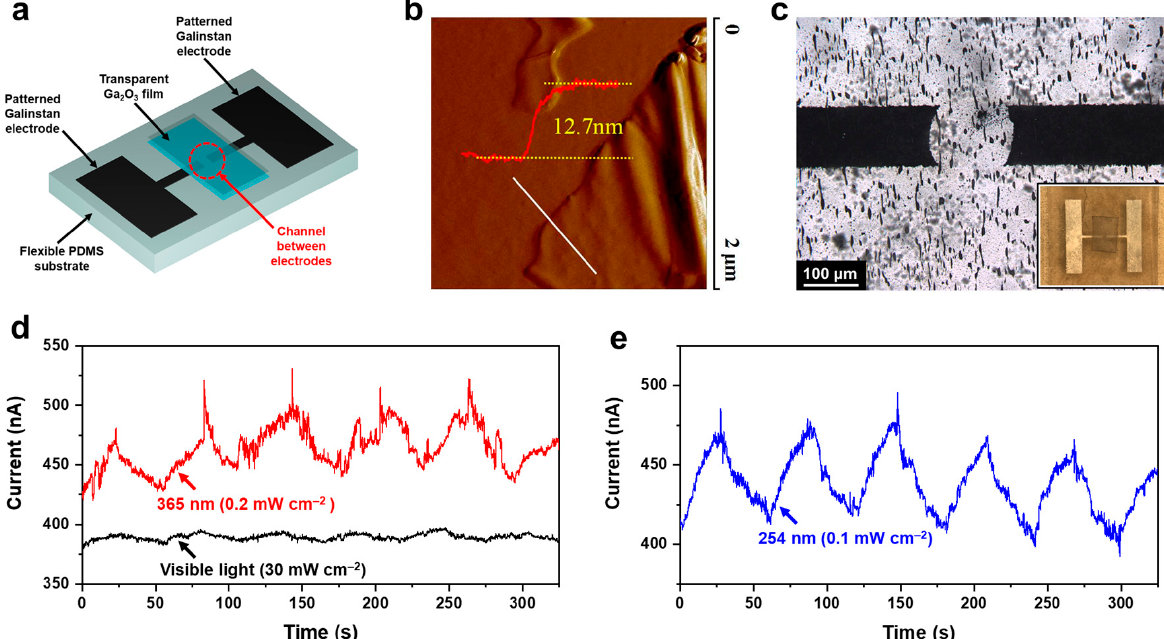
Figure 5. ( a ) Schematic illustration of solar-blind photodetector. ( b ) AFM image of transparent Ga 2 O 3 film, exfoliated using a PDMS stamp. The height profile along the white line is also indicated. ( c ) Optical microscopy image of a channel between two patterned Galinstan electrodes. The black areas correspond to Galinstan beneath the transparent Ga 2 O 3 film. Photograph of the fabricated photodetector is also shown in the inset. ( d ) Output characteristics of the solar-blind photodetector under irradiations of visible light (with a halogen lamp; ranging from 350 to 900 nm) and UV light of 365 nm wavelength, respectively. ( e ) Output characteristics of the solar-blind photodetector under deep UV irradiation (254 nm wavelength). The on/off switching of each irradiation was manually performed at 30 s intervals, and the output characteristics were constantly measured at a sample bias voltage of 0.1 V.